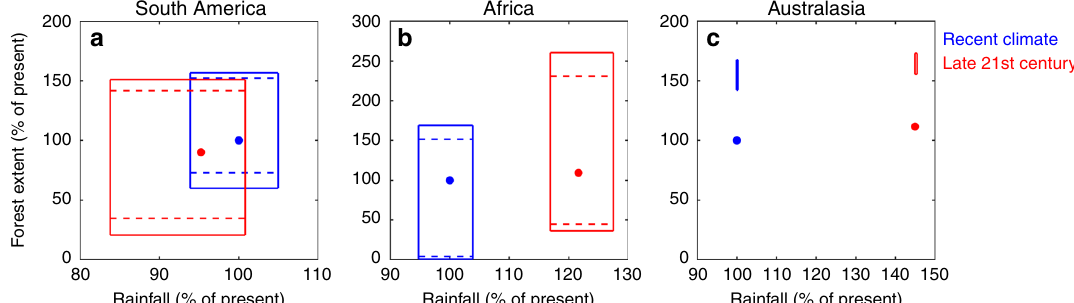
Fig. 3 The ranges of the intensity of the hydrological cycle and total forest cover under recent and late 21st century climate. Both the intensity of the hydrological cycle and total forest cover are given as percentage of their present value. The ranges that are delineated by solid lines result from the interaction of local-scale hysteresis of forest cover with regional-scale forest-induced moisture recycling, with those for the recent climate (2003 − 2014) given in red and those for the late 21st century climate (2071 − 2100) given in blue. The ranges that are delineated by dashed lines result from local-scale hysteresis only and do not account for regional-scale forest-induced moisture recycling (i.e. they assume ‘ static rainfall ’ ). Note that the static climates by de fi nition imply no ranges along the x -axis, but these ranges are kept for display purposes. Red dots indicate recent total annual rainfall and forest cover; blue dots indicate late 21st-century total rainfall and forest cover with no other factors than climate change considered. a South America; b Africa; and c Australasia. For spatial patterns in the ranges in rainfall levels, see Supplementary Figs. 6